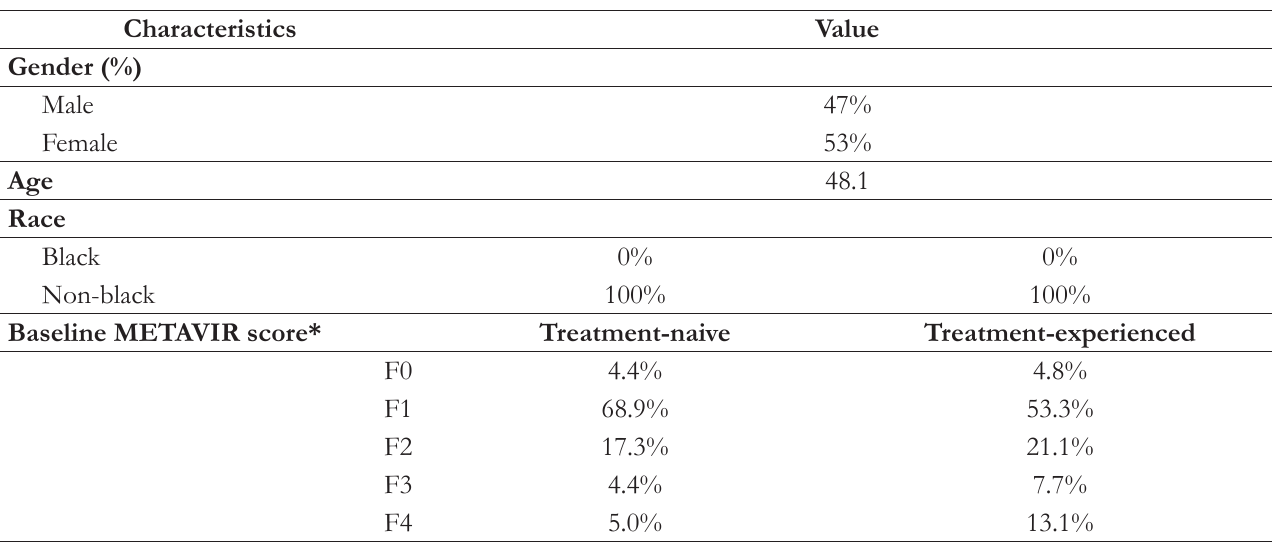
SVR=sustained viral response Table 1. Characteristics of Patients in the Model